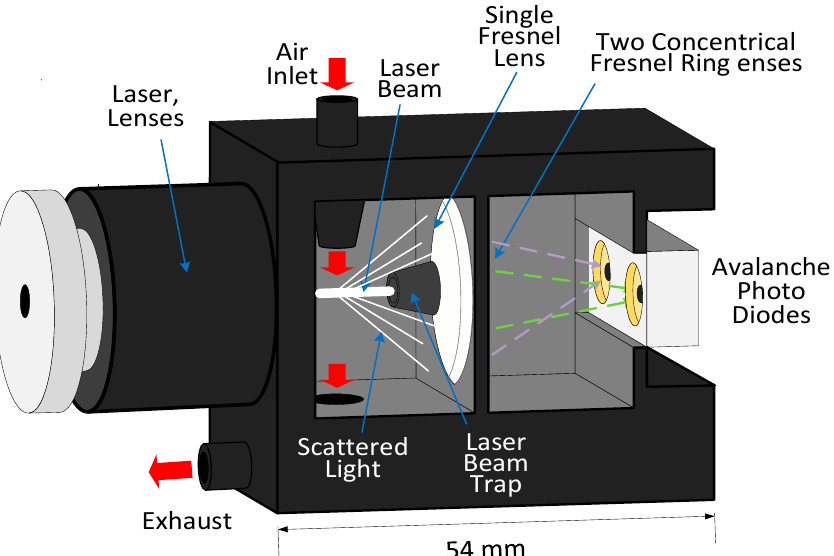
Figure 8. Fresnel ring lens-based OPC. Adapted with permission from Ref. [77]. © 2021 Optical Society of America.